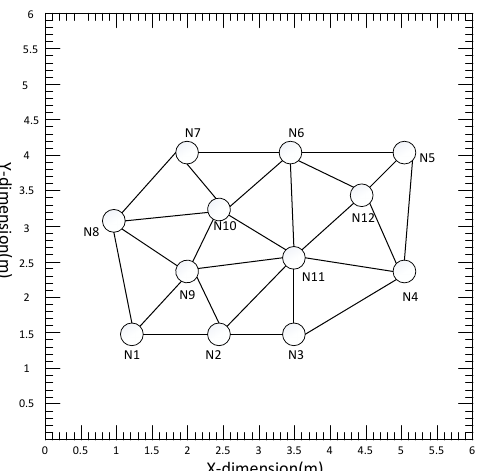
Figure 2. Diagram of a distributed acoustic sensor network with 12 nodes; circles represent nodes in the network. A pair of microphones was placed on each node, and the lines between the nodes indicate that the nodes can communicate with each other.